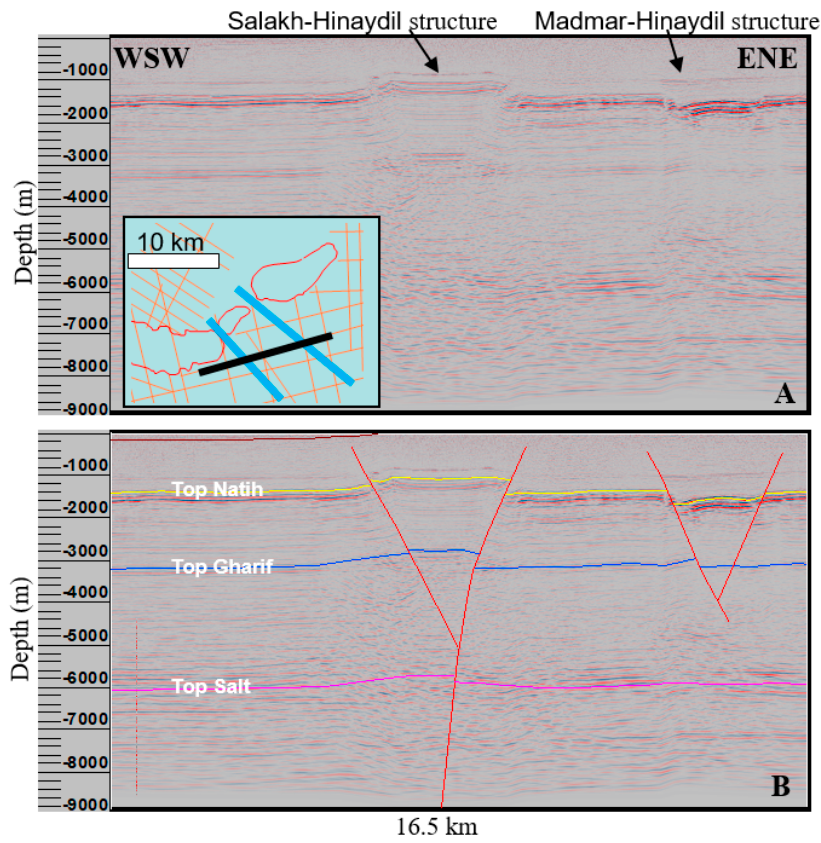
Figure 15. ( A ) interpreted and ( B ) uninterpreted seismic line along the southern flanks of the Salakh, Hinaydil and Madmar-Hinaydil gaps. The black line in the inset figure shows the location of the seismic section, whereas the blue lines show the orientations of the two structures through the gaps.